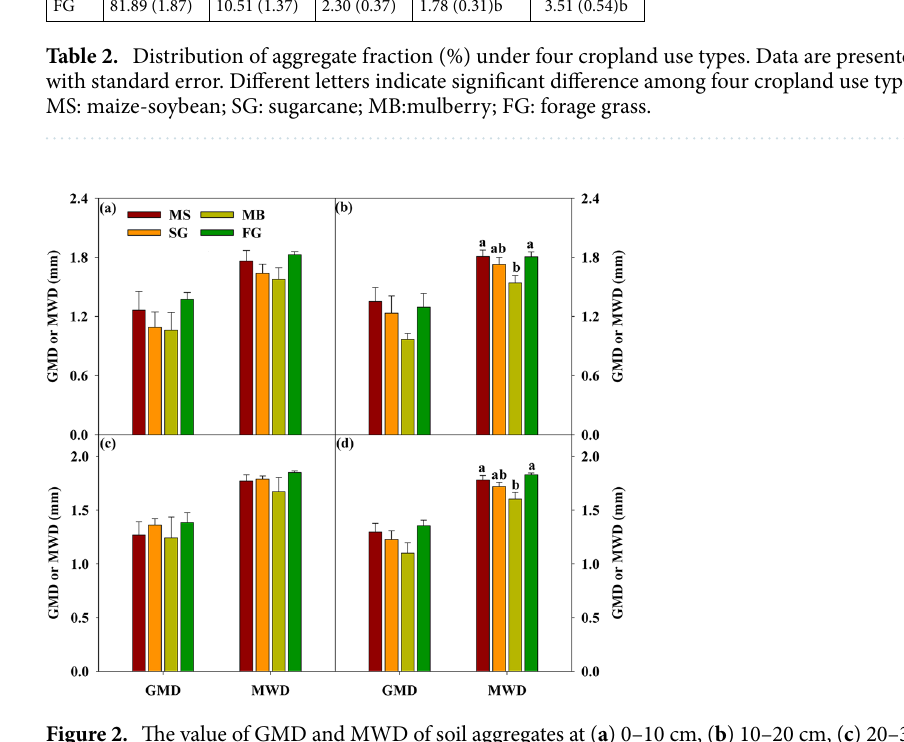
Figure 2. The value of GMD and MWD of soil aggregates at ( a ) 0–10 cm, ( b ) 10–20 cm, ( c ) 20–30 cm, and ( d ) 0–30 cm, respectively, under four cropland use types. Values presented as means with standard error. Different letters indicate significant difference at p < 0.05 among four cropland use types. MS: maize-soybean; SG: sugarcane; MB:mulberry; FG: forage